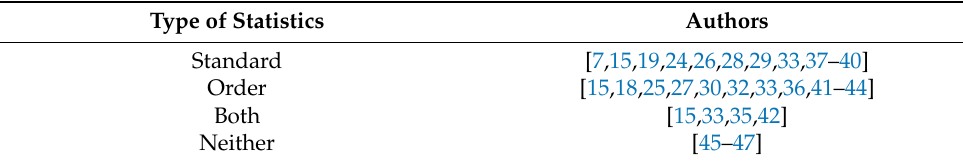
Table 3. Type of statistics used in each